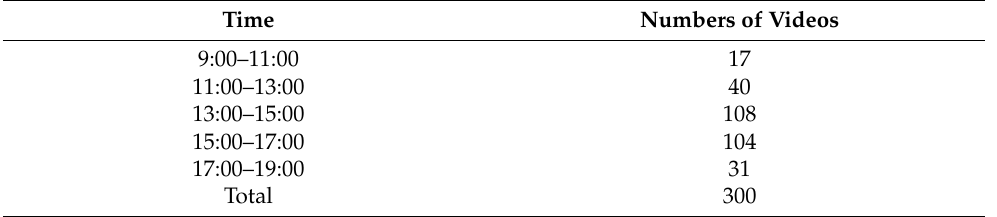
Table 1. Data time summary.